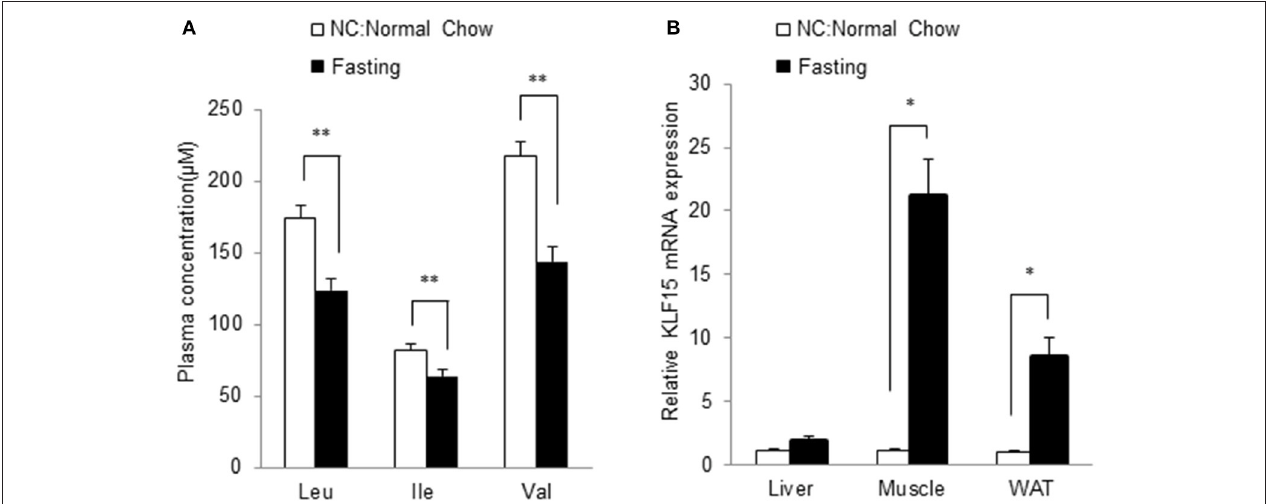
FIGURE 7 | Fasting leads to lower BCAA abundance and higher KLF15 expression in vivo . Mice at 10-week of age were fasted for 12h. Plasma levels of BCAAs were measured ( A , n = 7 in each group) and mRNA level of KLF15 in different tissues were analyzed with quantitative PCR ( B , n = 4 in each group). * p < 0.05, ** p <